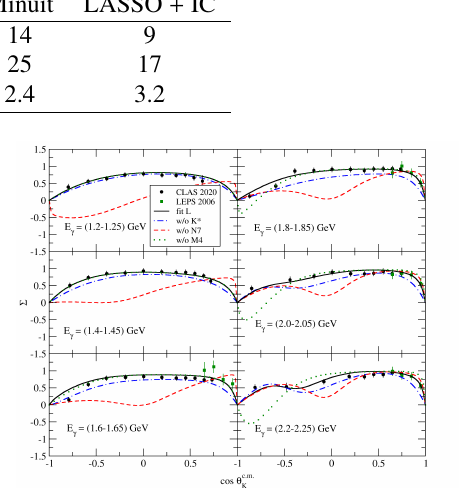
Figure 2. Photon beam asymmetry data com- pared to the full "fit M" results (solid line). Same fit, with the N (1720) 3 / 2 + (dashed line) and ∆ (1900) 1 / 2 − (dotted line) resonances omitted. The data are from CLAS [6] and LEPS [7] exper- iments.